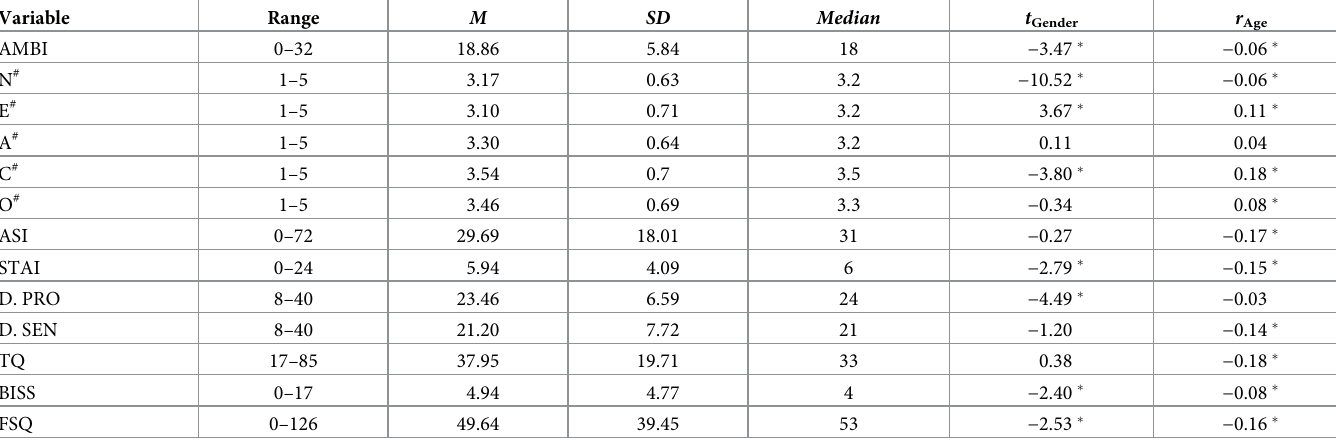
Table 2. Descriptive statistics ( N =